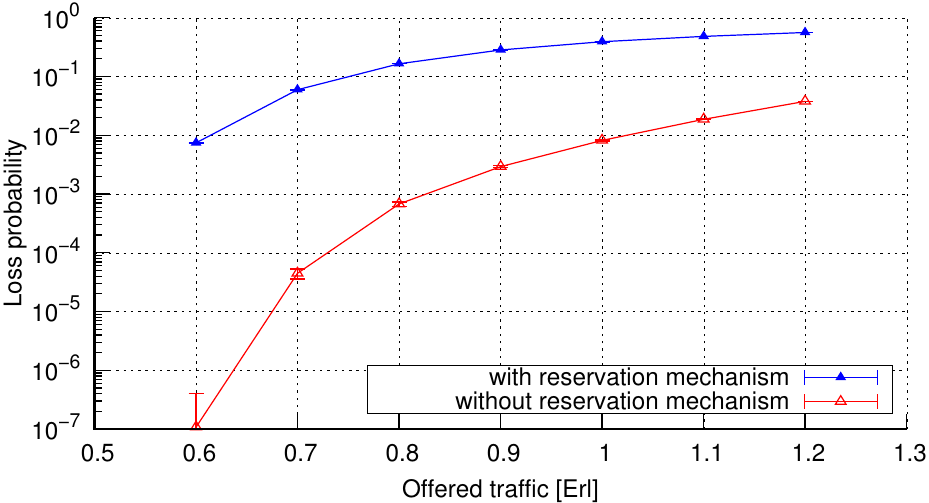
Figure 9. Loss probability for calls of class 2 (non-privileged class) in System